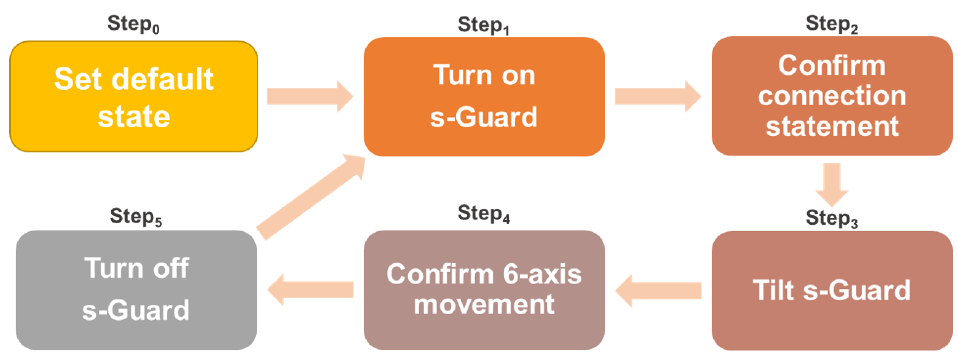
Figure 9. Connection success check test scenario cycle.